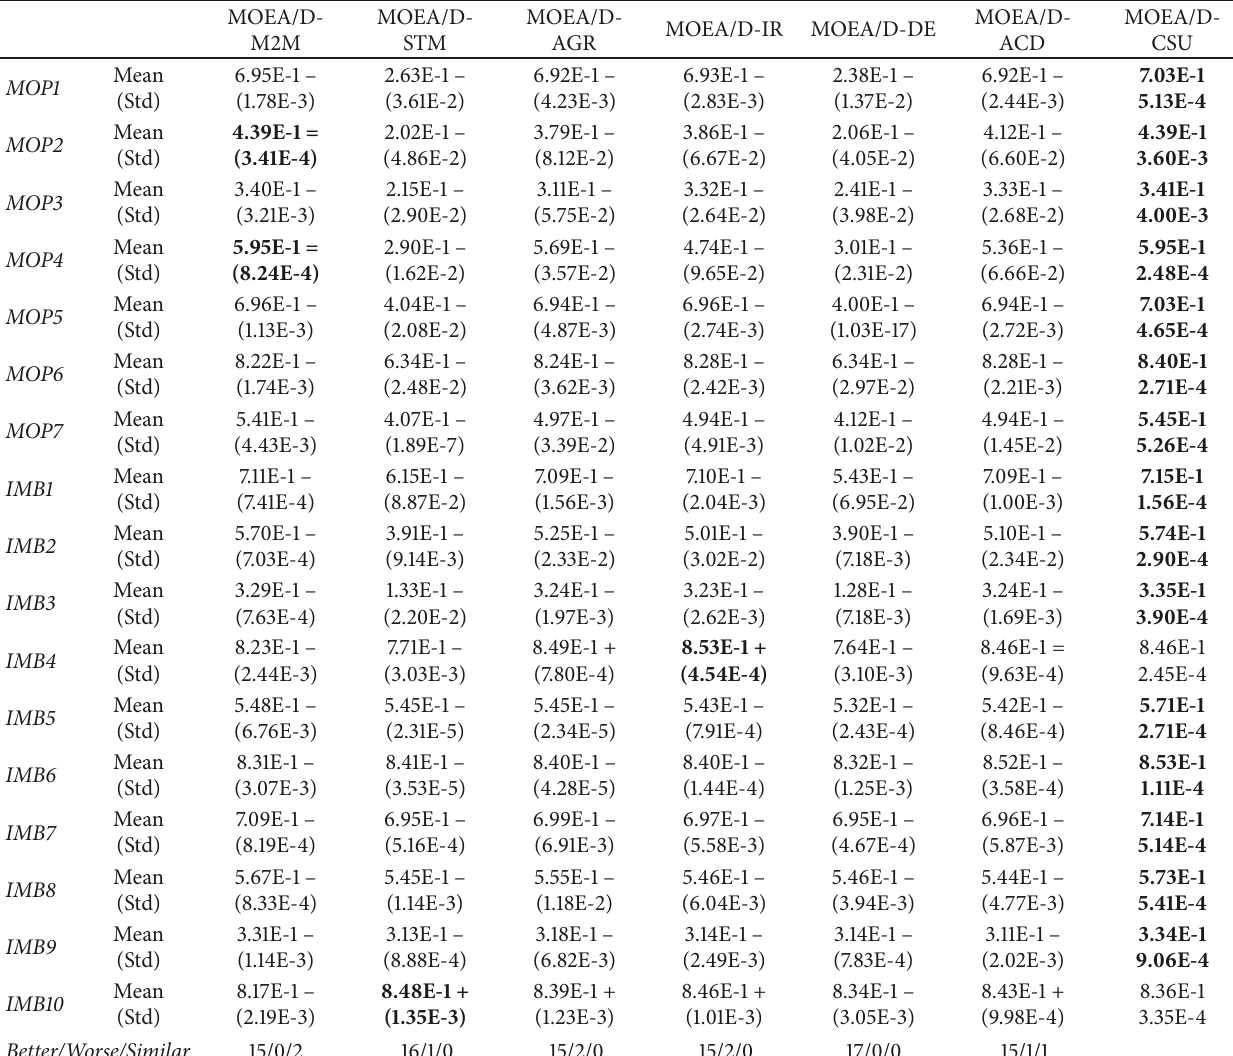
Table 2: HV comparison of results of MOEA/D-CSU and six competitors on all the MOP and IMB test